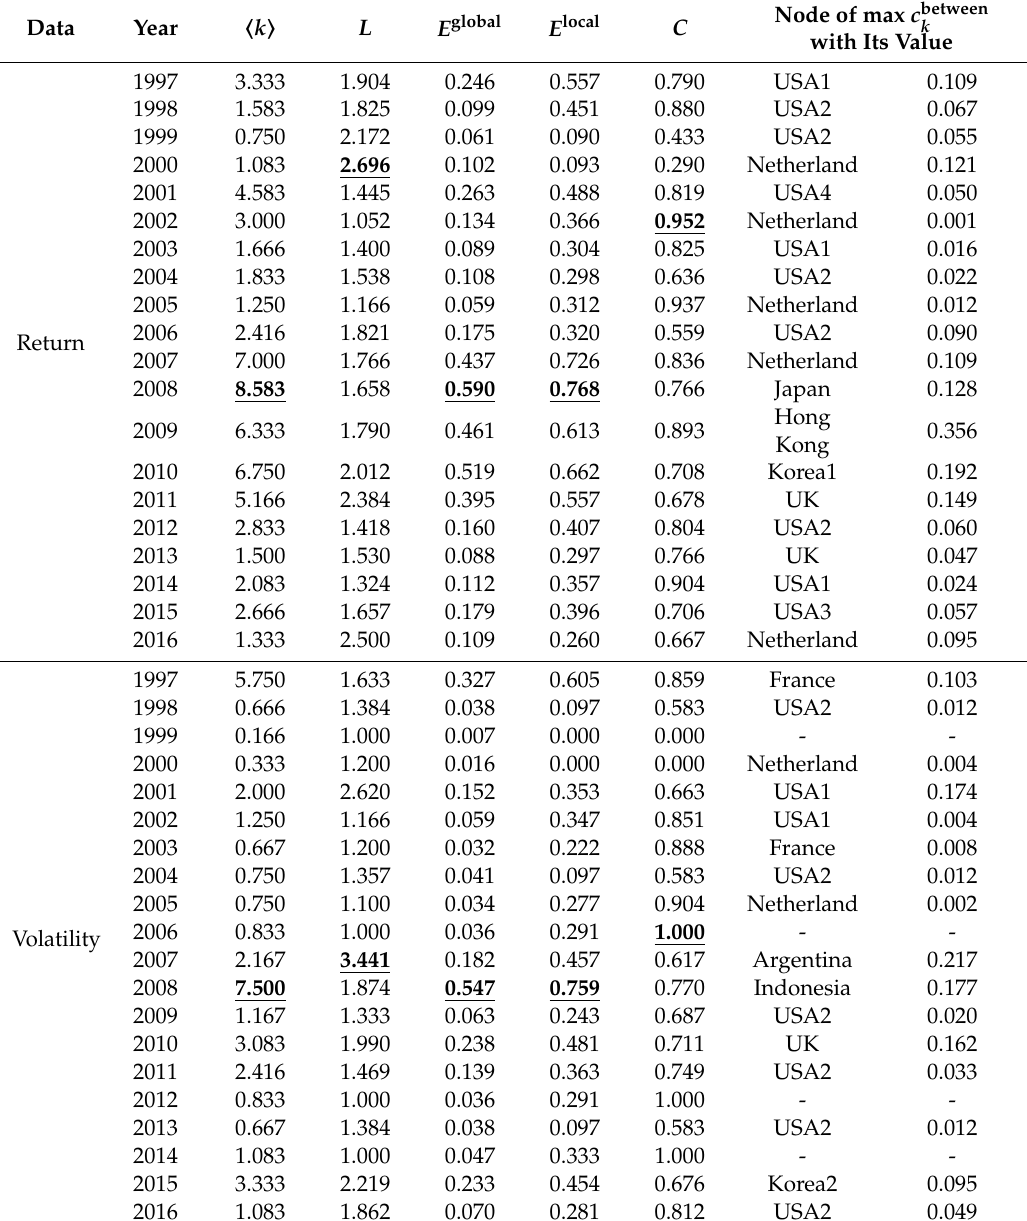
Table A1. Network properties of global 24 stock markets generated by DCCA methodology partitioned with 1-year